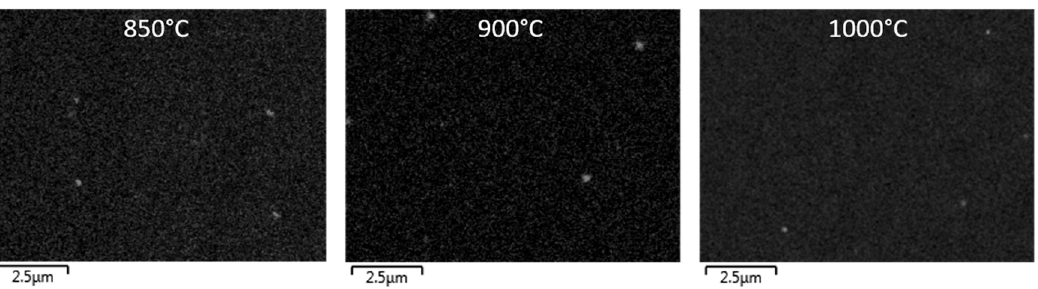
Figure 6. Typical images of niobium distribution in the microstructures produced by various soaking temperatures, obtained by EDS (Energy-dispersive X-ray spectroscopy) mapping. Light dots correspond to Nb enriched particles.